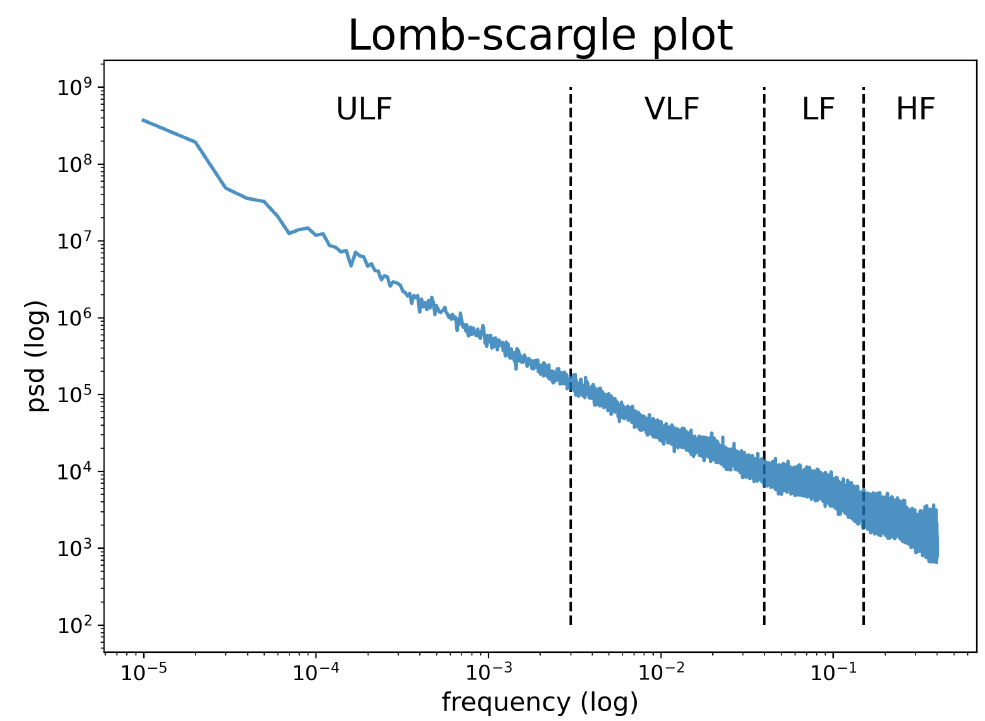
Figure 1. Power spectrum density plot obtained by Lomb-Scargle Periodogram. Lower values obtained from SDANN24 and SDANN HR 24 compared to